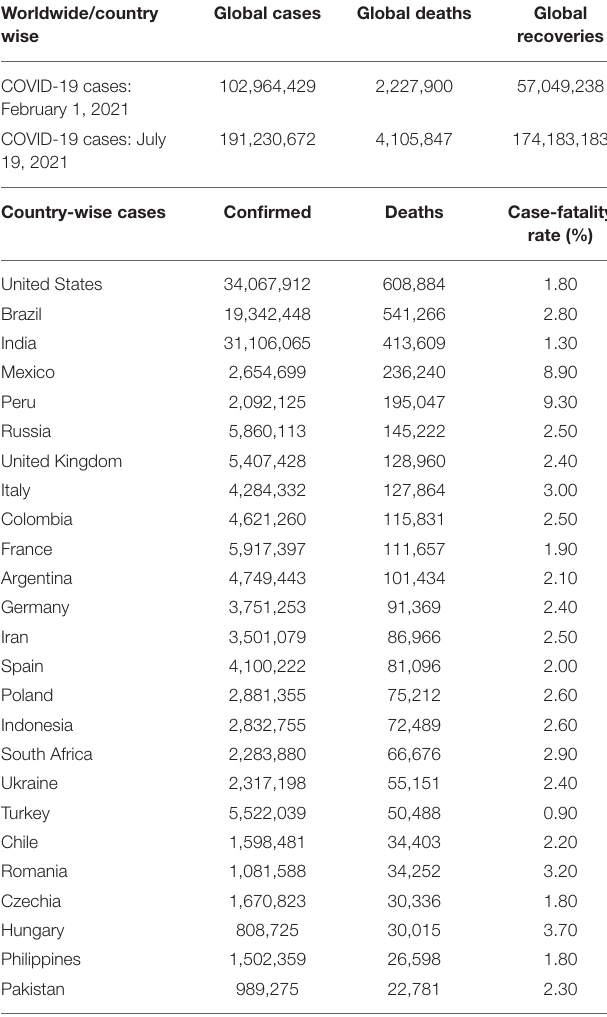
TABLE 2 | The COVID-19 global cases in various affected countries as of July 18, 2021. Worldwide/country Global cases Global deaths Global wise